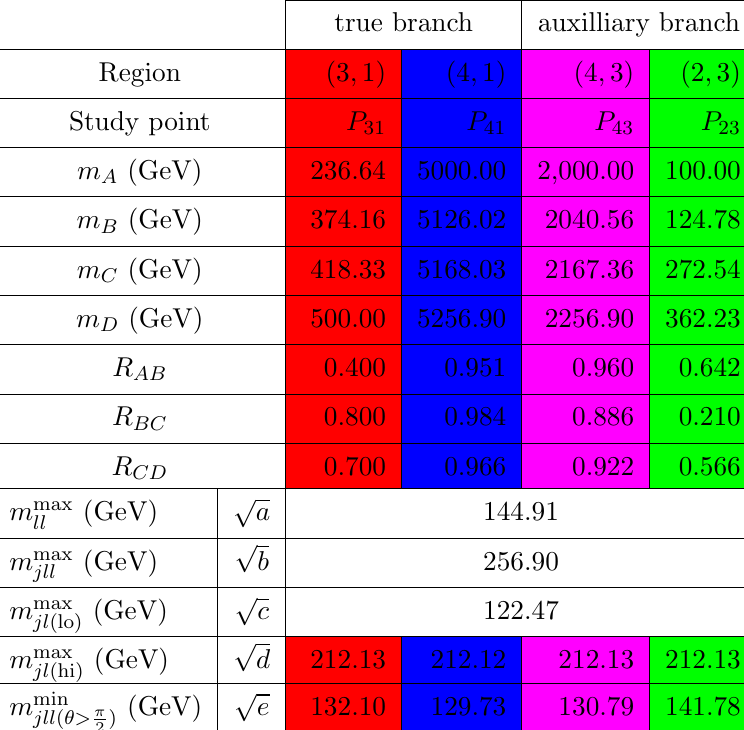
Table 1 . Mass spectrum and expected kinematic endpoints for the study point P